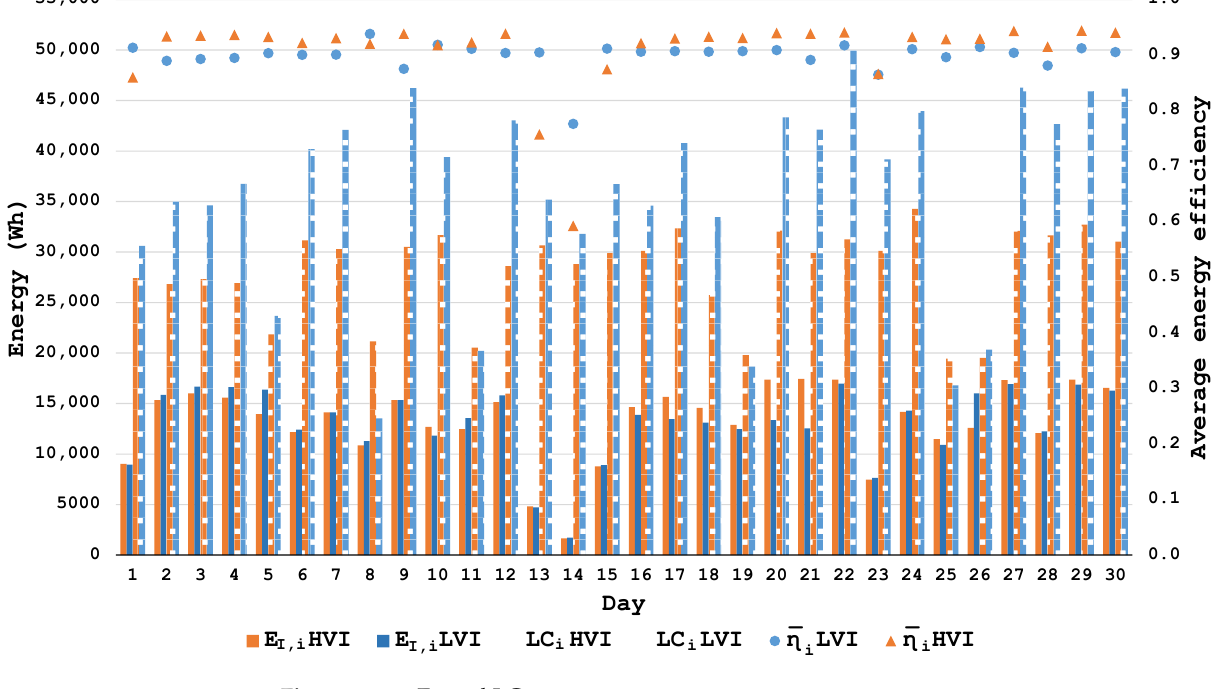
Figure 10. η i , E I , and , E I , and LC. Figure 10. 𝜂𝜂 𝚤𝚤 �